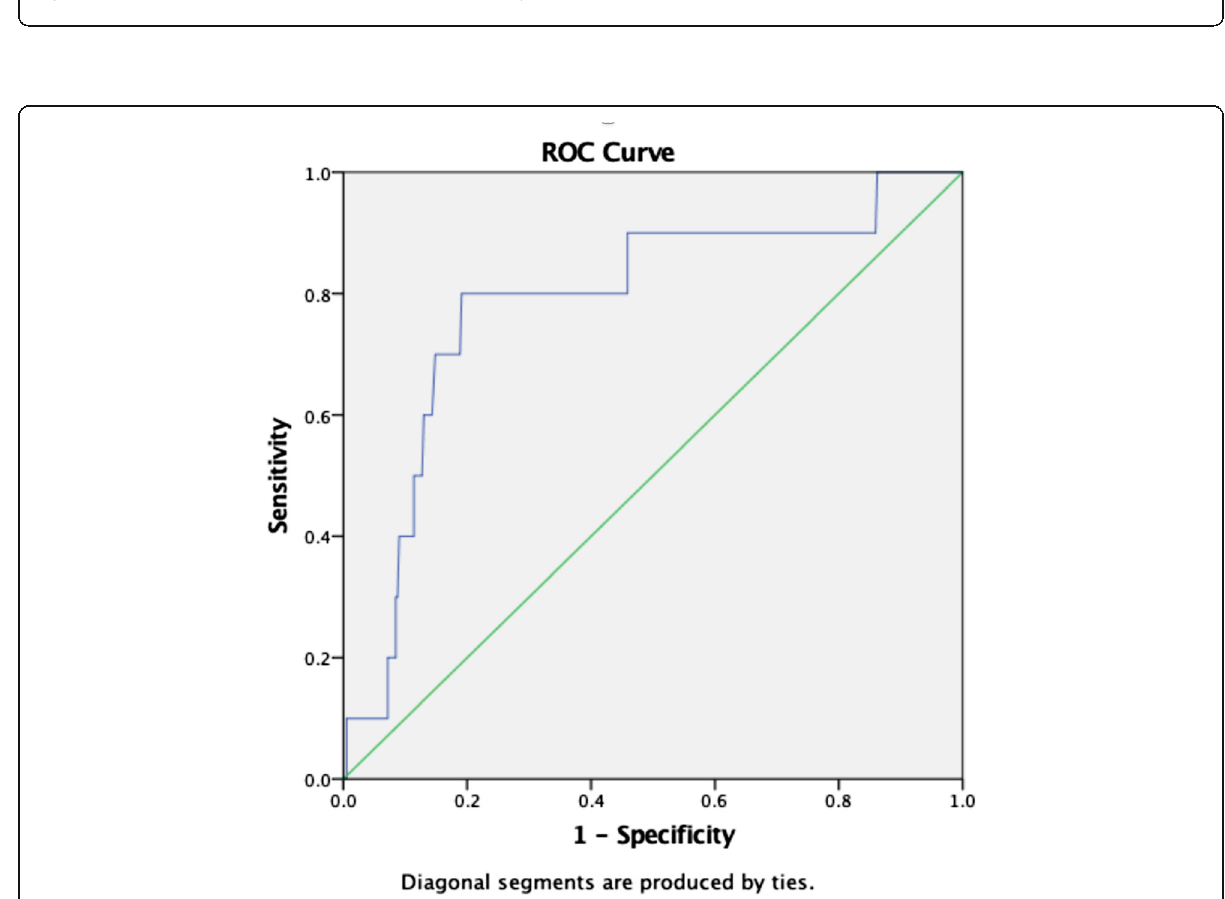
Fig. 3 Graphic representation of ROC curve for need for